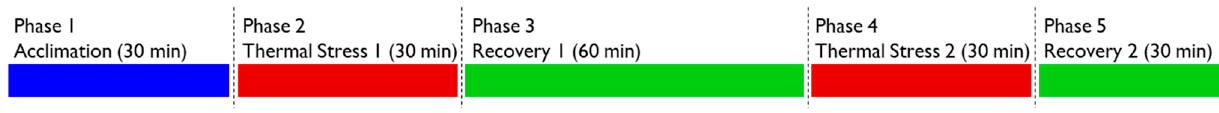
Figure 3. Five phases of the experiment to evaluate responses to cool and warm exposures.